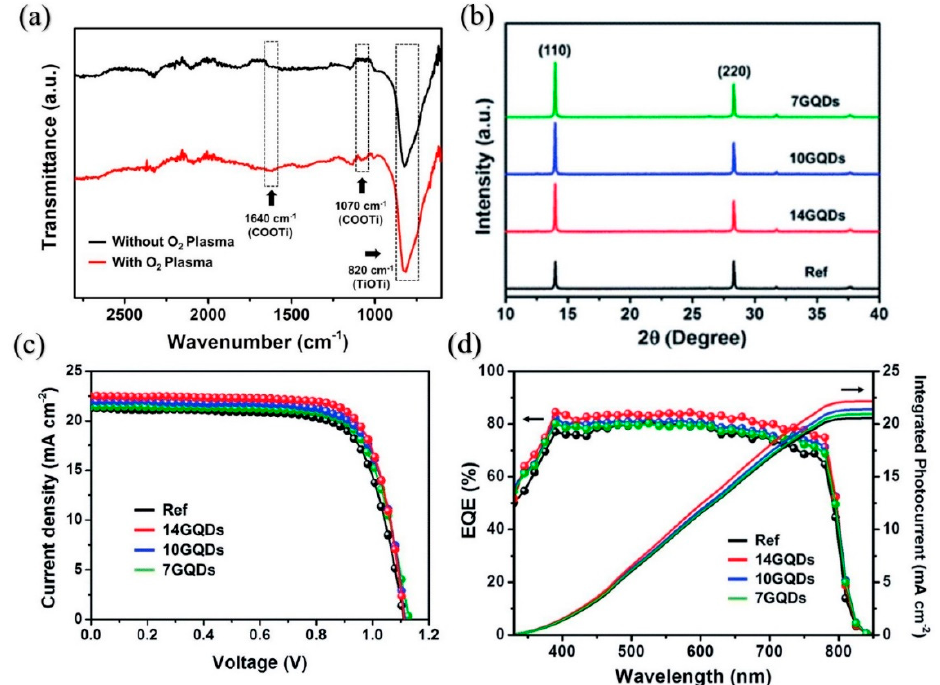
Figure 3. ( a ) FTIR spectra of TiO 2 -GQDs with and without O 2 plasma treatment, ( b ) XRD patterns of perovskite on pristine TiO 2 and TiO 2 -GQDs (14 nm, 10 nm, 7 nm), ( c ) current density-voltage (J-V) characteristics of PSCs, ( d ) external quantum efficiency (EQE) (or incident photon-to-current efficiency (IPCE)) spectra and integrated photocurrents of PSCs [18] (republished with permission from the Royal Society of Chemistry, conveyed through Copyright Clearance Center, Inc.).